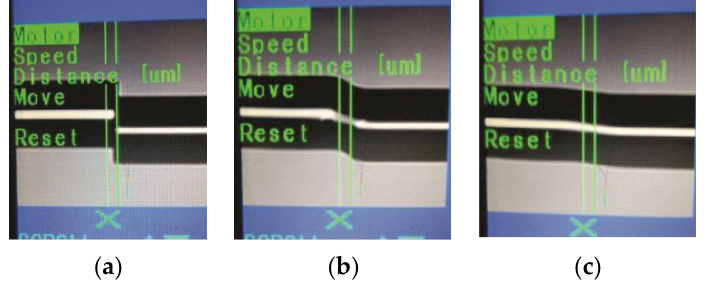
Figure 2. Fabrication process of the Mach-Zehnder interferometer (MZI) ( a ) Initial position with a core offset section with lateral of 30 µm; ( b ) Splice joint between single mode fiber (SMF)|non-zero dispersion-shifted fiber (NZ-DSF); ( c ) Spliced image of SMF|NZ-DSF.